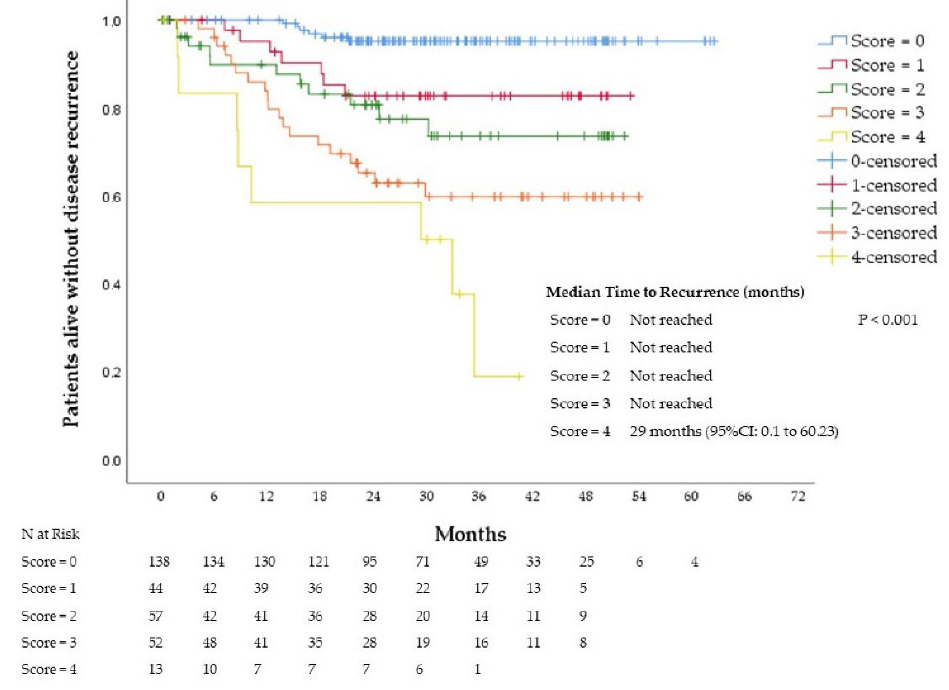
Figure 2. Time to recurrence according to the score (0–4) in the training cohort. A total of 100 patients were included in the validation cohort. The baseline charac- teristics are depicted in Table 1. The median age at diagnosis was 75 years (range 45–97), and 50% of the patients were female. The primary tumor was distributed equally in the right and left colon. Stage II was observed in 54% percent of the patients each. Twenty-one percent of the patients had high tumor budding. A total of 43 patients received adjuvant chemotherapy. Patients were assigned to the low-risk ( n = 46; 46%) and high-risk ( n =